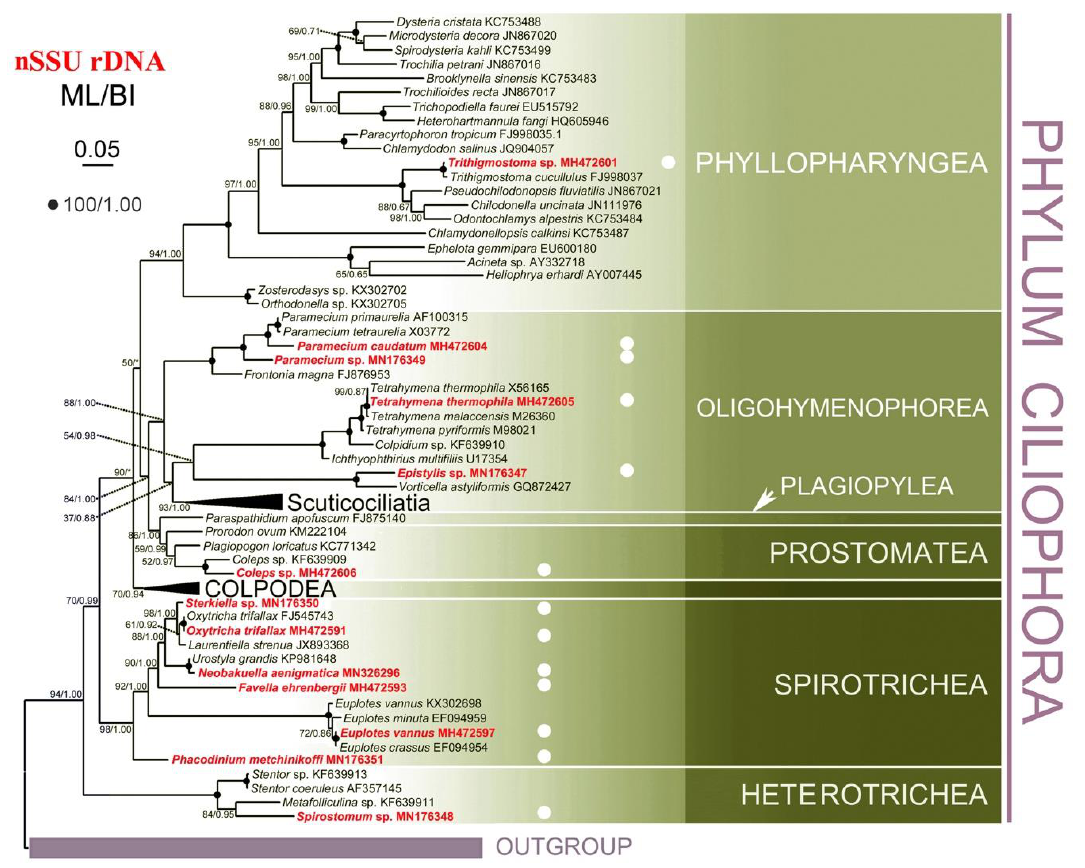
Figure 4. The maximum likelihood (ML) tree based on nSSU rDNA sequence alignment, highlighting the 13 species studied. Numbers near nodes represent the bootstrap values of ML and the posterior probability values of Bayesian analysis (BI). Dots (.) mean fully supported node (100 / 1.00) while asterisks (*) indicate the disagreement between ML and BI topologies. The scale bar corresponds to two substitutions per 100 nucleotide positions. All branches are drawn to scale.